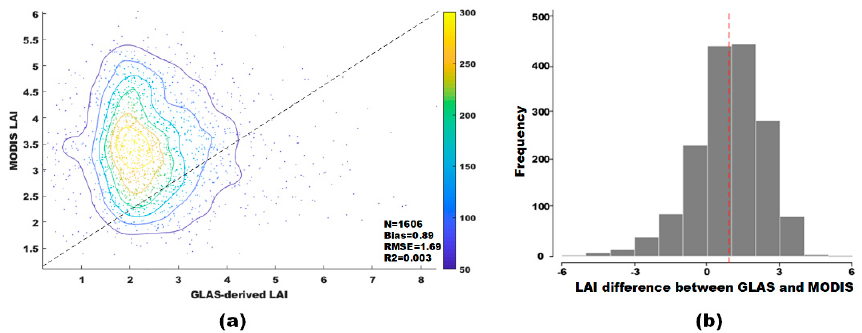
Figure 15. ( a ) Scatter plot of averaged GLAS LAI against MODIS LAI at the 500 m pixel level. The legend explains the number of data points that fell into certain square areas. ( b ) Histogram of LAI difference between GLAS and MODIS; the red line indicates the bias (0.89).